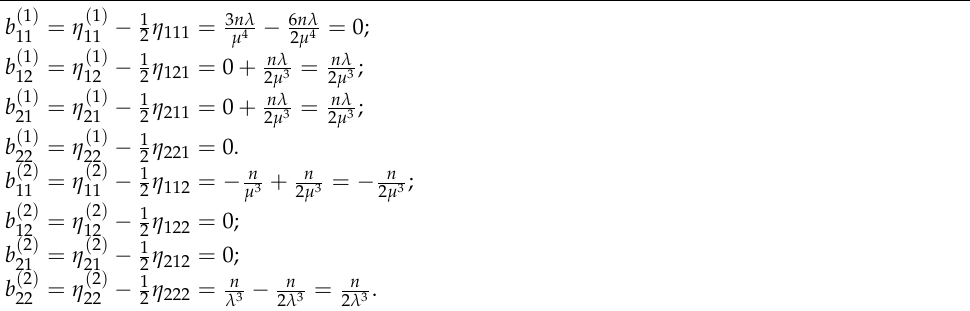
Table A3. The entries of B